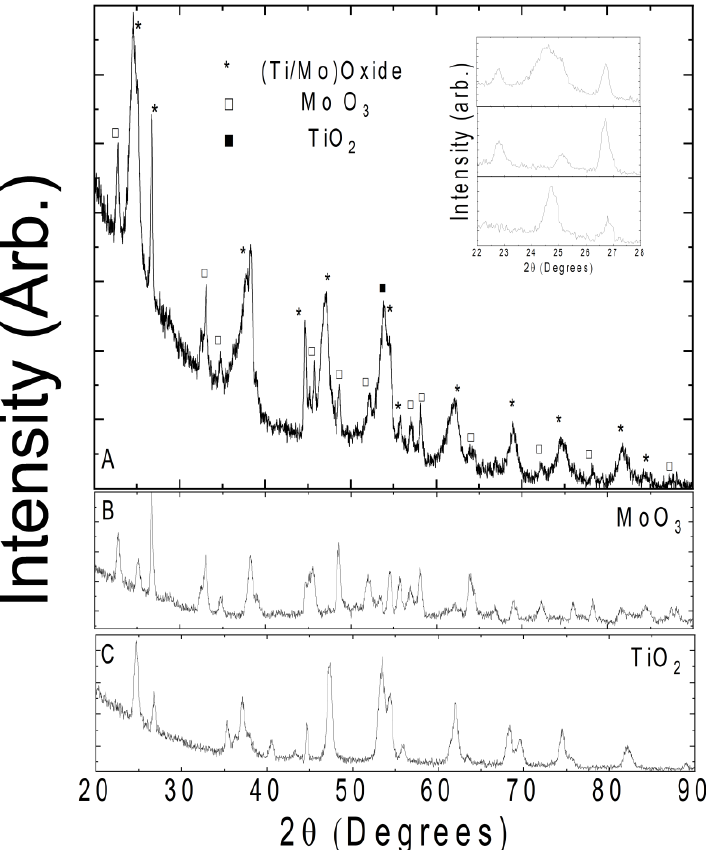
Figure 3. ( A ) X-ray diffraction pattern of Ti-Mo NC; inset: zoomed-in view of lower angle ranges for clarification of the peak broadening. The ( B , C ) show the reference spectra of constituent TiO 2 and MoO 3 powders.